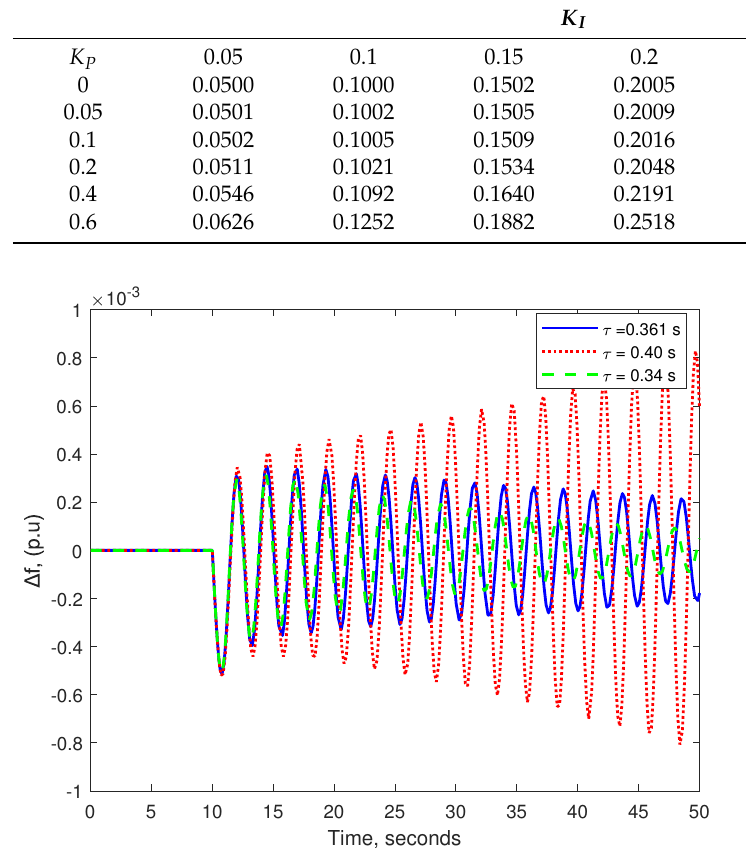
Table 3. Crossing frequencies, ω c , rad/s.